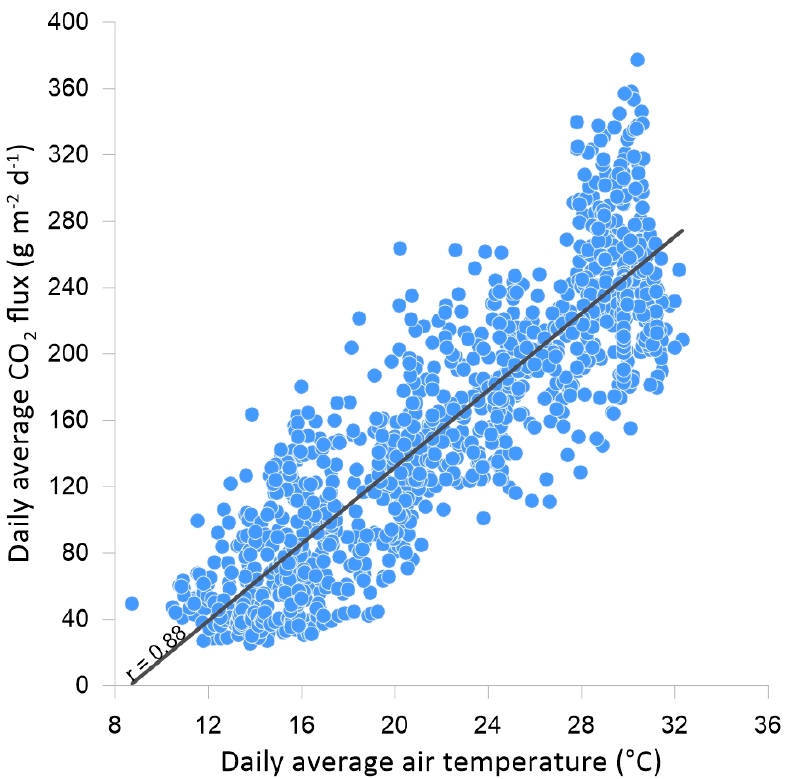
Figure 5. Correlation graphic between daily CO 2 fluxes and air temperatures. A high correlation has been found, with R 2 equal to 0.88. To analyze in detail the behavior of CO 2 flux and air temperature during the period of 2017–2020, we calculated their yearly cumulated probability (Figure 6a,b). There is a progressive increase of CO 2 fluxes (Figure 6a) during the period mentioned above, while the range between winter minima and summer maxima air temperatures (Figure 6b) contemporarily decreases (from 22 to 16 ◦ C), due to both higher winter minima and lower summer maxima air